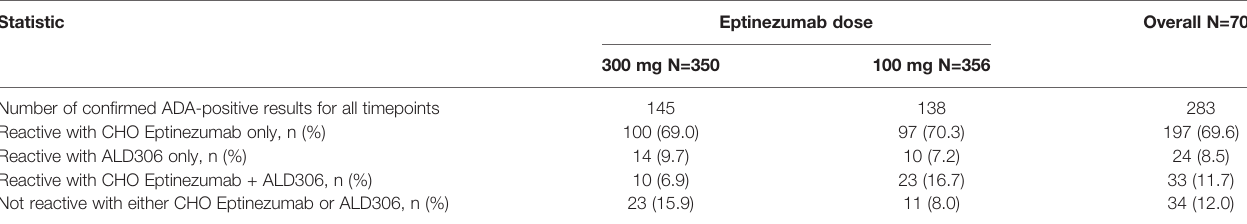
TABLE 4 | Speci fi city of ADA signals detected in study eptinezumab PROMISE 2 Study (all timepoints). Statistic